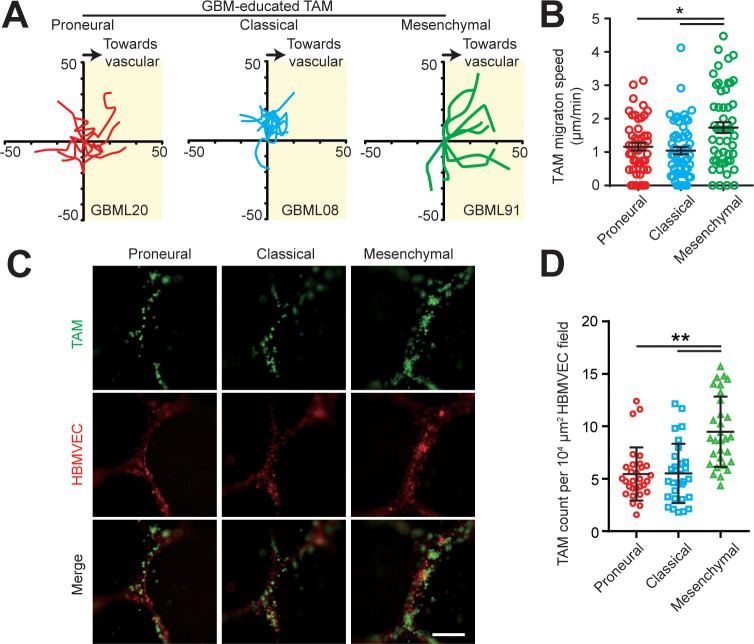
TAM motility and adherent behaviors in the engineered tumor microenvironments of different GBM subtypes.(A) Representative trajectories of embedded TAM movements in a 2 hr observation window in different GBM subtypes. (B) Quantified results showing faster TAM movement towards the vascular side in the MES (GBML91) GBM as compared to the CL (GBML08) and PN (GBML20) GBMs. Error bars represent ± s.e.m. p-Values were calculated using one-way ANOVA. *, p<0.05. (C) Representative staining images showing different subtypes of GBM-educated TAMs adherent to HBMVECs. TAMs were plated into 24-well plate with HBMVEC monolayer and cultured for 12 hr, followed by 3 times washing with warm media. Scale bar is 200 µm. (D) Number of adherent TAMs to HBMVEC were counted and plotted as cell number per 104 μm2 HBMVEC field. p-Values were calculated using unpaired two-tailed Student’s t-test, N = 30, **p<0.01.